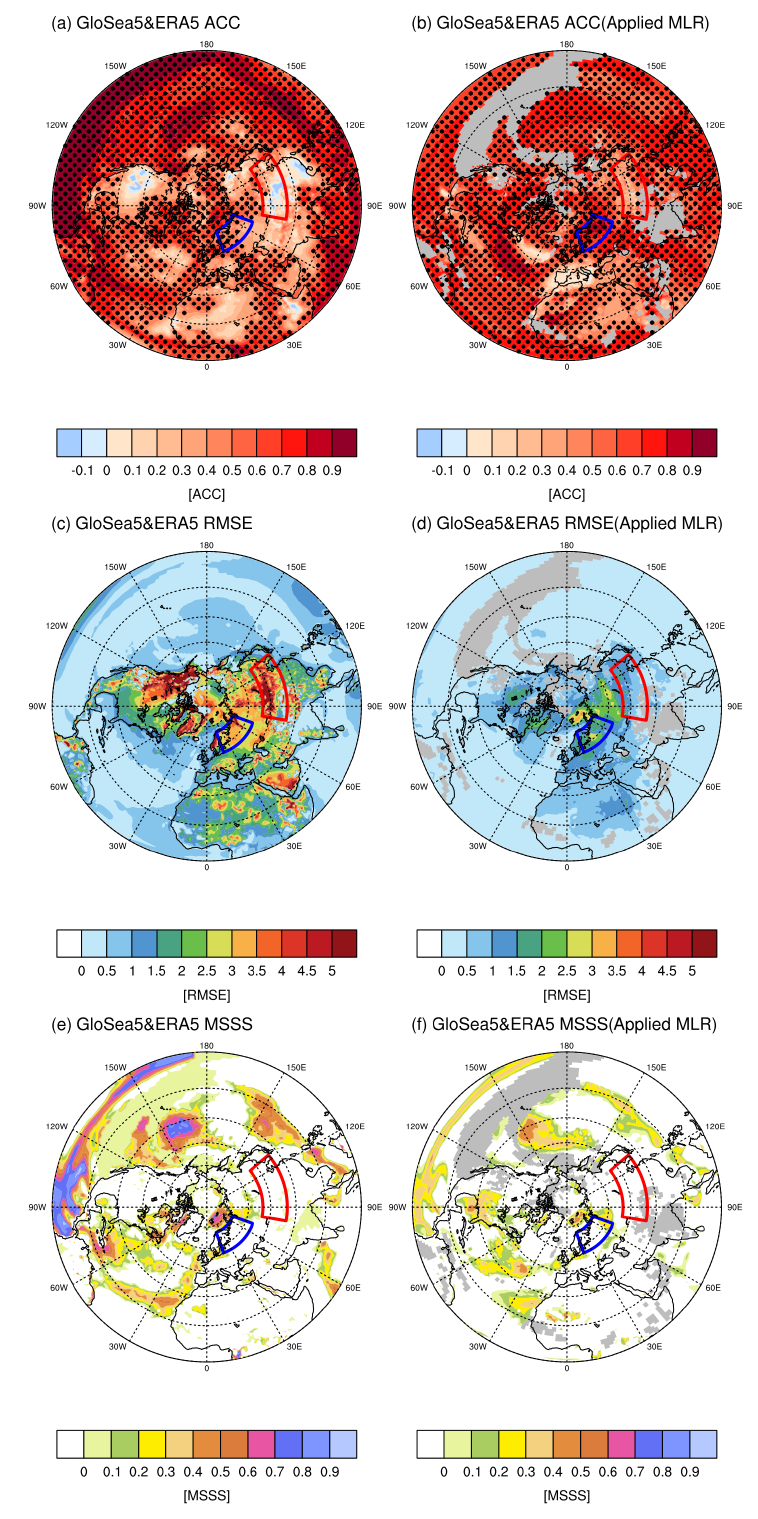
Figure 5. The spatial distribution of surface temperature (T2m, K) between the ERA5 data and GloSea5 hindcast during boreal wintertime (DJF) from 1979 to 2019. The left side is for the GloSea5 model ( a , c , e ), and the right is for the GloSea5 model with the MLR model (applied MLR) ( b , d , f ). Top : Anomaly correlation coefficient (ACC); Mid : Root mean square error (RMSE); Bottom ; Mean- squared skill score (MSSS). The blue and red boxes indicate the areas of East Asia and Northern Europe, respectively. The black dots indicate statistical significance at the 95% confidence